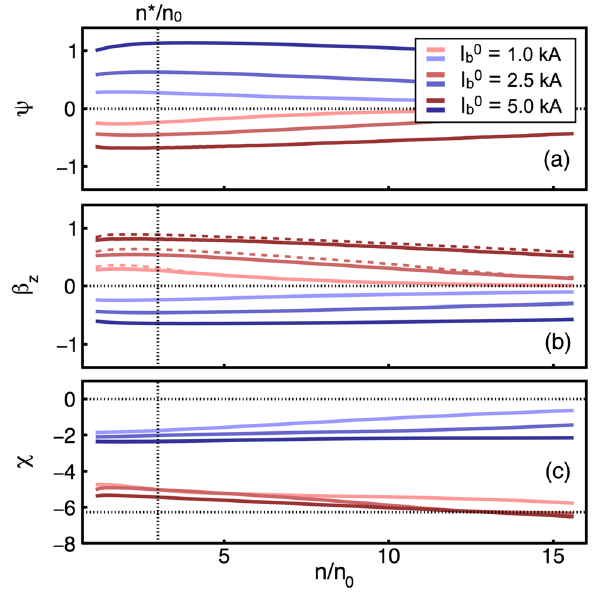
FIG. 5. (a) Maximum (red curves) and minimum (blue curves) values of the (on-axis) wakefield potential ψ as a function of the plasma density, from 3 PIC simulations with drive-beam peak current of 1 . 0 ; 2 . 5 , and 5.0 kA. (b) Longitudinal velocity of the plasma electrons calculated from the ψ values in panel (a) by means of Eq. (8). Dotted curves show the actual maximum electron velocity β z; as retrieved from the simulations. max (c) Phase-position of the extrema of ψ . The red curves show the value of χ 1